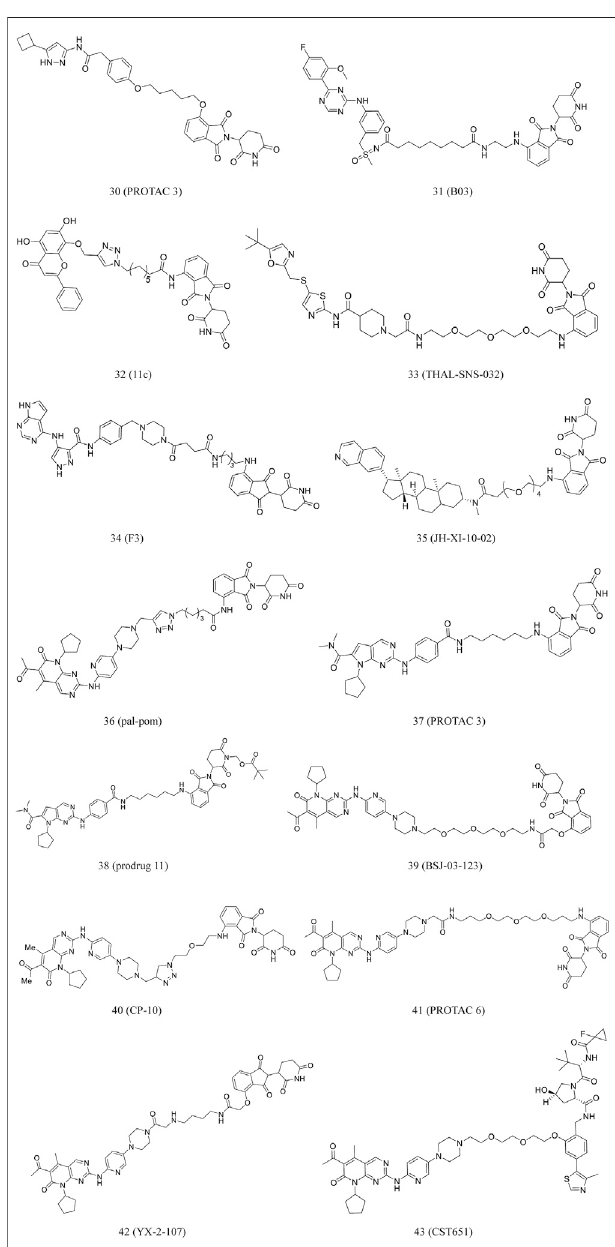
FIGURE 7 | Chemical structures of PROTACs targeting